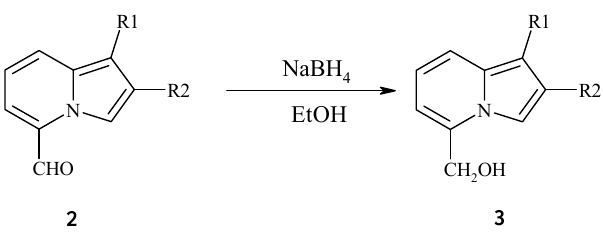
Table 5. Characteristics of 5-CH